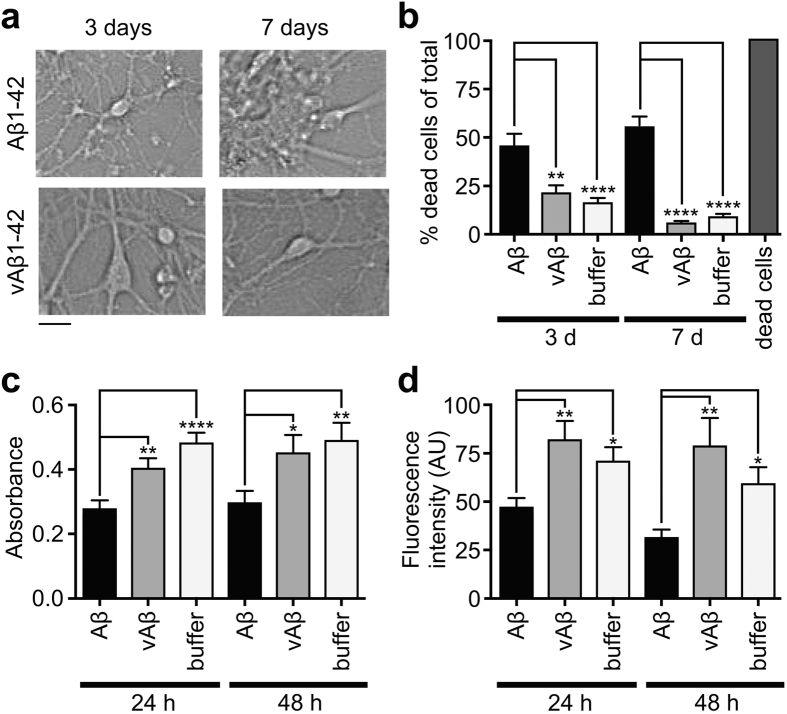
(a) DIC widefield images of neurons live in culture following treatment with either Aβ1-42 oligomers or vAβ1-42 after 3 or 7 days. Some live neurons are still clearly visible in the Aβ1-42 culture after 3 days but by 7 days none appear healthy. Scale bar 20 μm. (b) Measurement of proportion of dead cells compared to the total counted in culture by Readyprobes assay following 3 and 7 days exposure to Aβ1-42 or vAβ1-42 or buffer only (total number of cells counted (number of dead cells in brackets) at 3 days: n = 1163 (545), 1012 (220) and 1661 (279) and 7 days: n = 1032 (610), 684 (37) and 1112 (97) for Aβ1-42, vAβ1-42 and buffer respectively). (c) MTT assay (24 hours: n = 19, 9 and 20, 48 hours: n = 14, 9 and 13 for Aβ1-42, vAβ1-42 and buffer respectively) and (d) CTB (24 hours: n = 12, 11, and 16, 48 hours: n = 12, 9, and 18 for Aβ1-42, vAβ1-42 and buffer respectively) assay using SH-SY5Y cells. 10 μM oligomeric Aβ1-42 has a significant effect on the cells after 24 hours whilst vAβ1-42 is the same as buffer only. Unpaired parametric student’s t test, only significant differences are shown, where p = < 0.05 (*), <0.01 (**), <0.0001 (****) and >0.05 was not significant. Error bars are expressed as ±SEM.